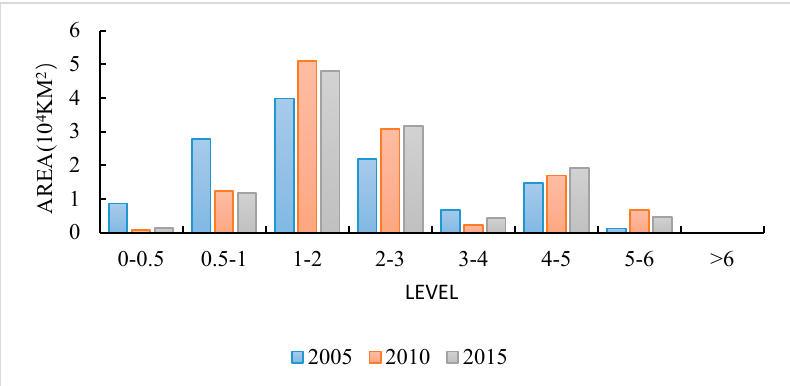
Figure 12. Comparison of different levels of LAI in the Loess Plateau Ecological Screen from 2005 to 2015.